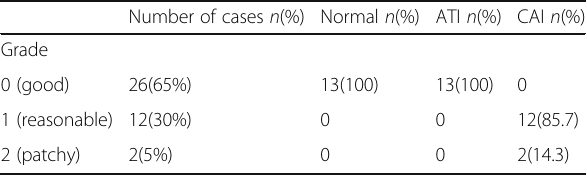
Table 1 Perfusion grades correlating to histopathology in the 3 studied